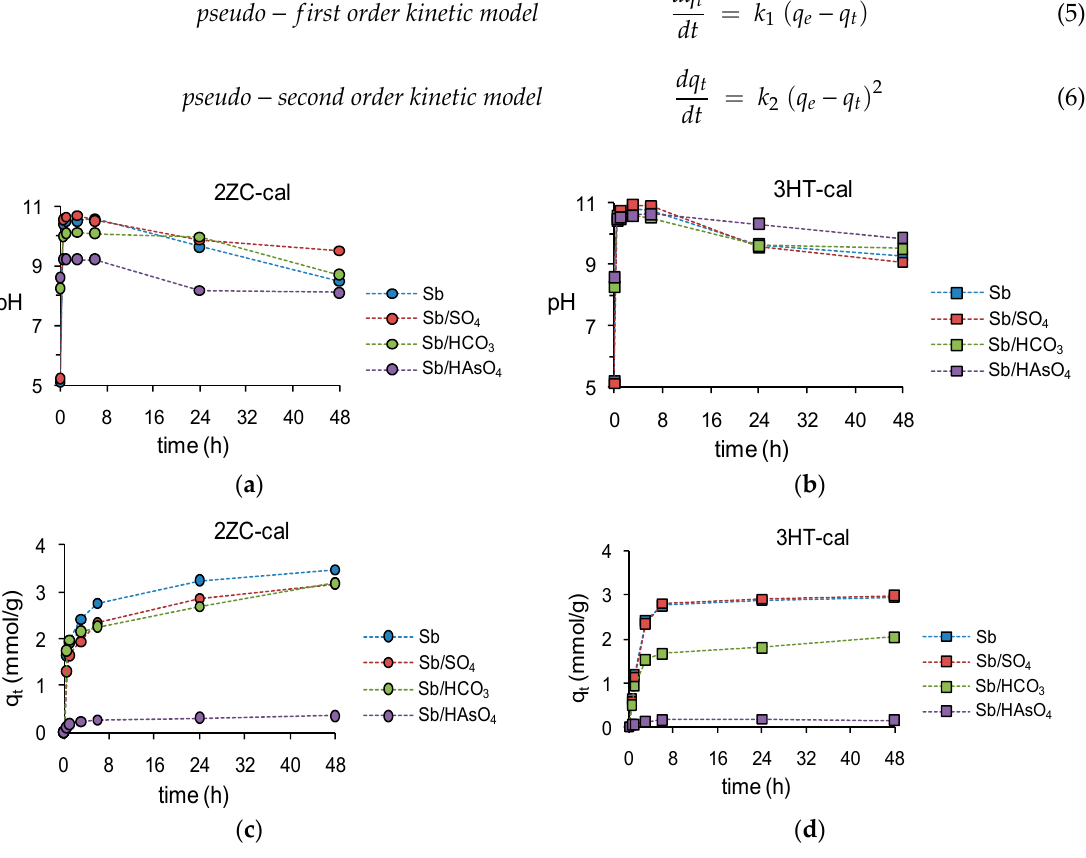
Figure 2. The solution pH values determined as a function of time during the sorption experiments without competitors and with coexistent anions performed with ( a ) 2ZC-cal and ( b ) 3HT-cal. The Sb(OH) 6 − sorption capacity (q t ) as a function of time in the experiments performed with ( c ) 2ZC-cal and ( d ) 3HT-cal without competitors and with coexistent anions.